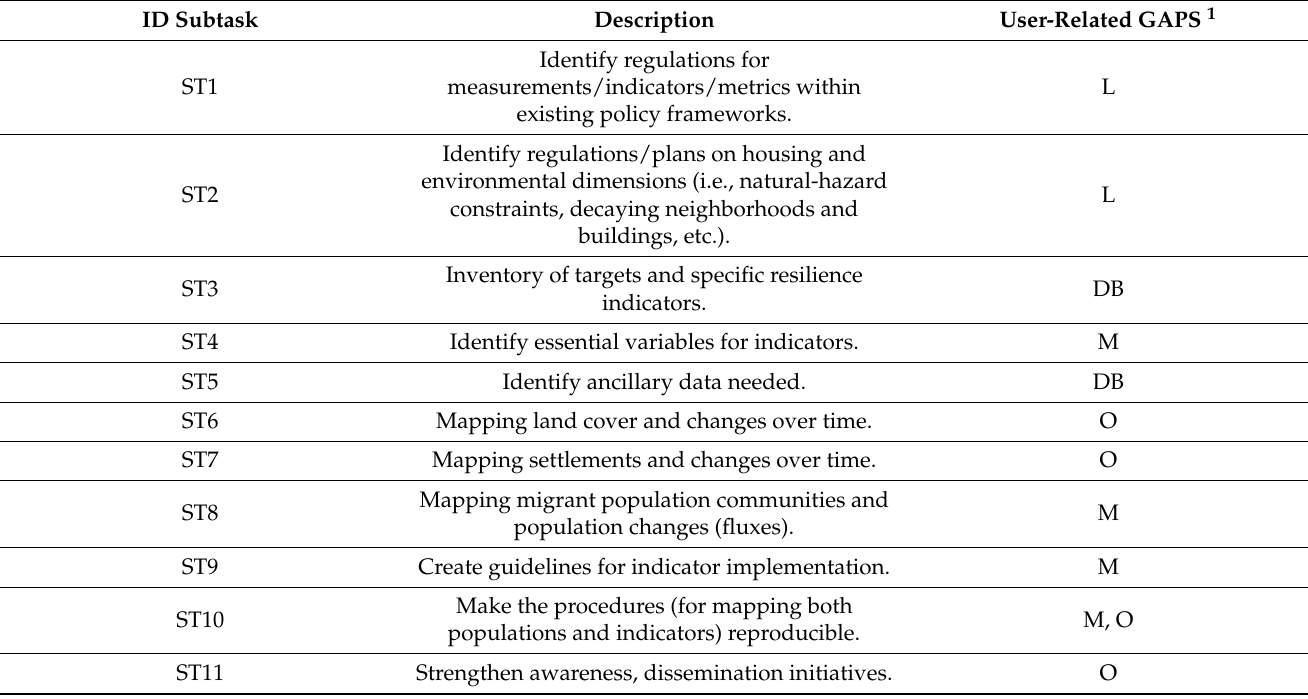
Table 3. List of subtasks in relation to user